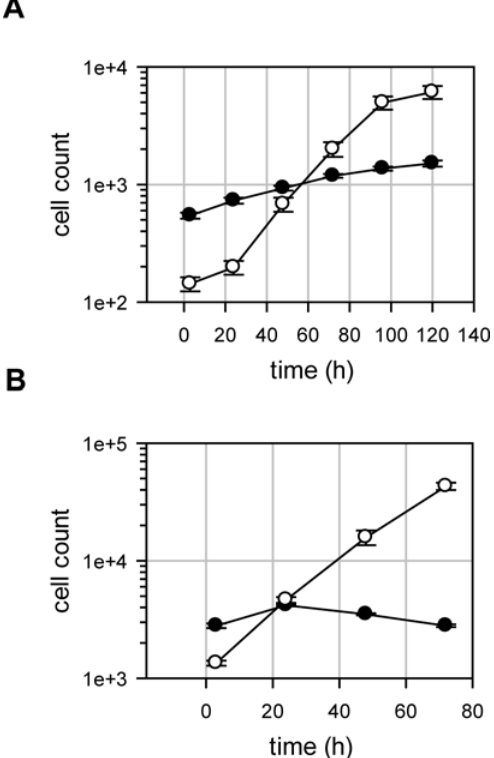
Fig 2. Replication of host cells and amastigotes. Panel A. A time-course was carried under assay conditions and plates were fixed every day followed by imaging and analysis. The full circles show the host cell counts and the open circles show the amastigote counts (n = 384 wells, error bars are standard deviations). The doubling time for the amastigotes was determined in the exponential growth window (between 24 and 96 h). Panel B. A time-course was carried out using gamma-irradiated Vero cells. Plates were fixed every day followed by imaging and analysis. The full circles show the host cell counts and the open circles show the amastigote counts (n = 18 wells from a single experiment, error bars are standard deviations).